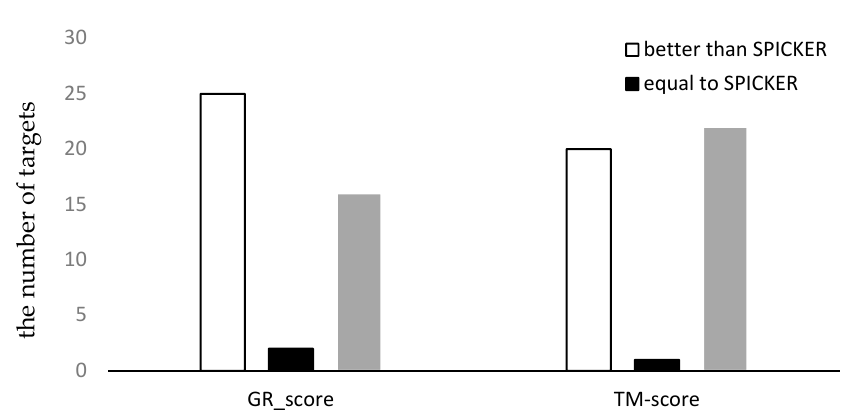
Figure 5. The comparison of the two methods using both GR_score and TM-score for datasets from CASP10.